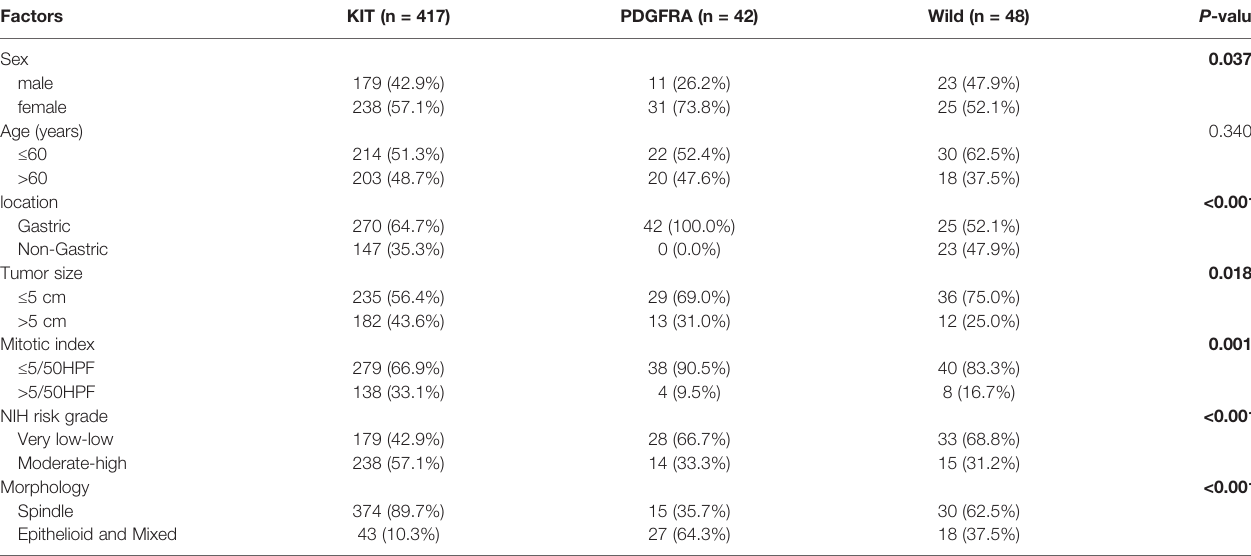
TABLE 1 | Relationship between gene mutation types and clinicopathological features.